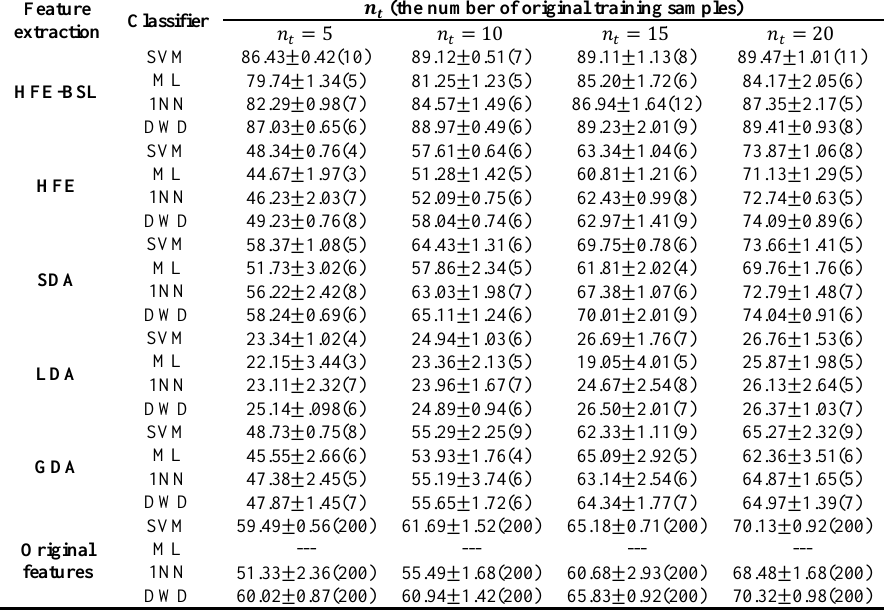
Table 7. Highest average classification accuracies and their corresponding standard deviations achieved using SVM, ML, 1NN and DWD classifiers with features extracted by HFE-BSL, HFE, SDA, LDA, GDA, and using original features for Indian dataset. Number in parenthesis represents number of features achieving highest accuracies in experiments.